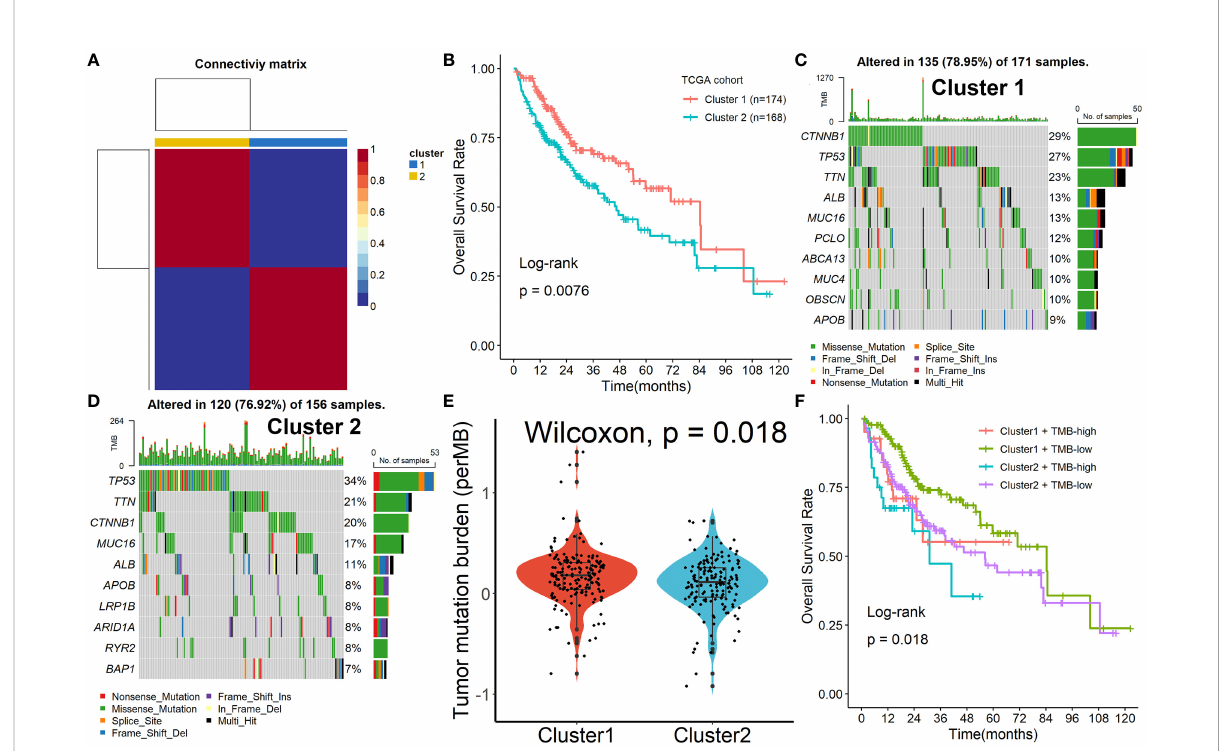
FIGURE 2 Identi fi cation of prognostic molecular subtypes by the NMF algorithm. (A) Number two was identi fi ed as the optimal number of clusters. (B) Patients in Cluster 2 had better survival outcomes when compared with patients in Cluster 1. (C, D) The mutation rates of mutated genes in the two subgroups. (E) Patients in Cluster 1 had a higher TMB value, compared with patients in Cluster 2. (F) Patients in Cluster 2 with high TMB values had the worst survival outcomes when compared with